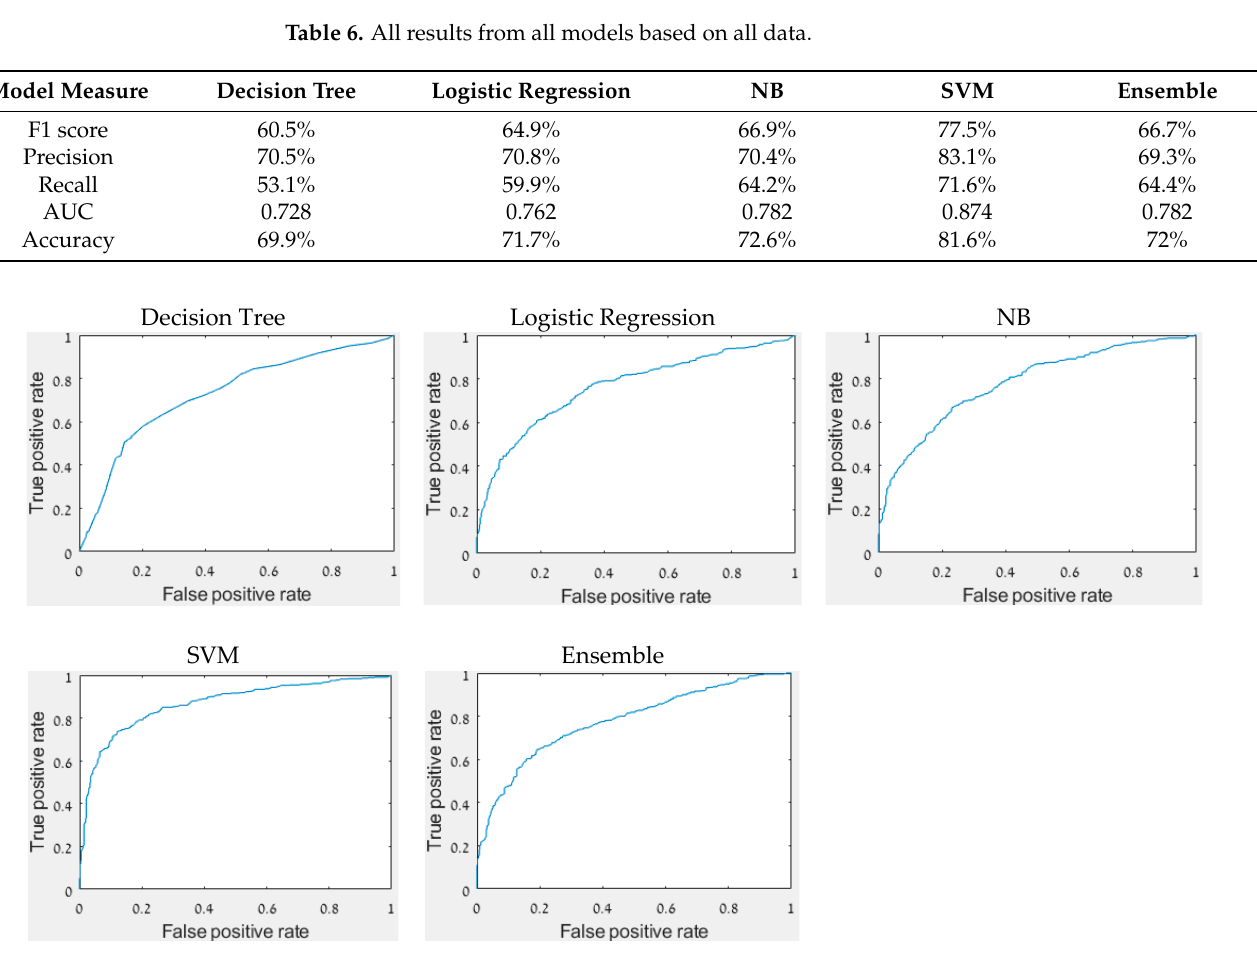
Figure 3. The ROC curve of each model.